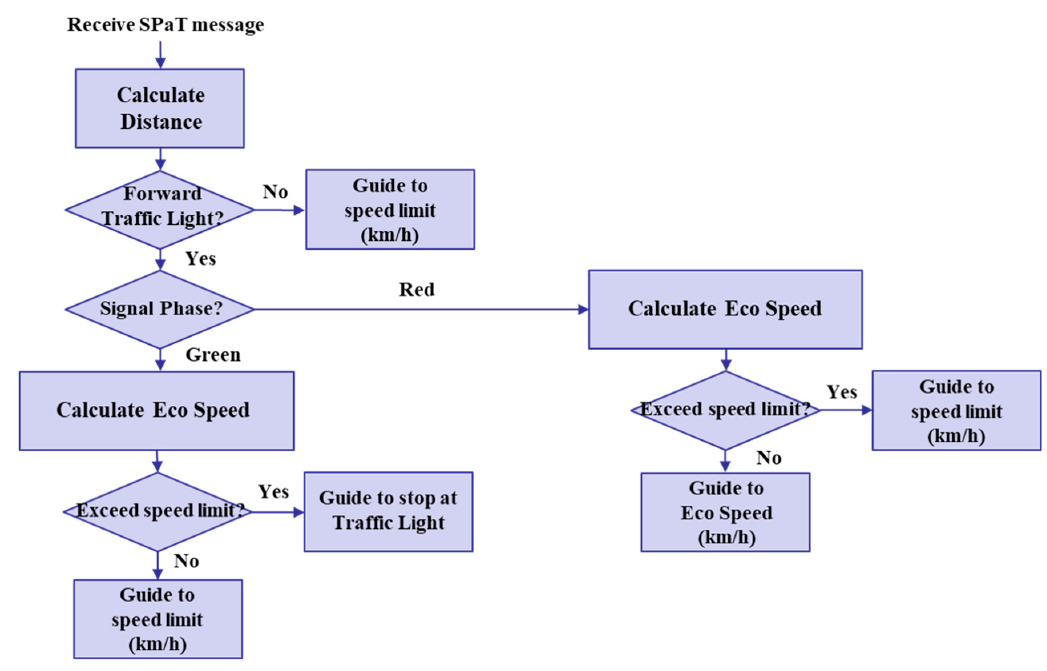
Figure 5. Flowchart of cooperative eco-driving speed guidance application.